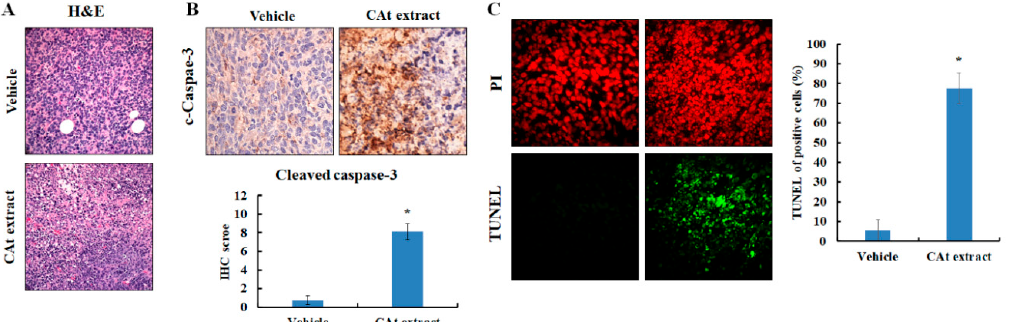
Figure Figure 6. CAt-extract-induced apoptosis in the HCC xenograft tumor model by H&E, immunohistochemical (IHC), and TUNEL staining. ( A ) Tissue morphology, evaluated with H&E staining. ( B ) CAt-extract-induced cleaved caspase-3 expression. ( C ) TUNEL staining for the observation of apoptotic cells. *: A significant difference between control and treatment, p < 0.05.